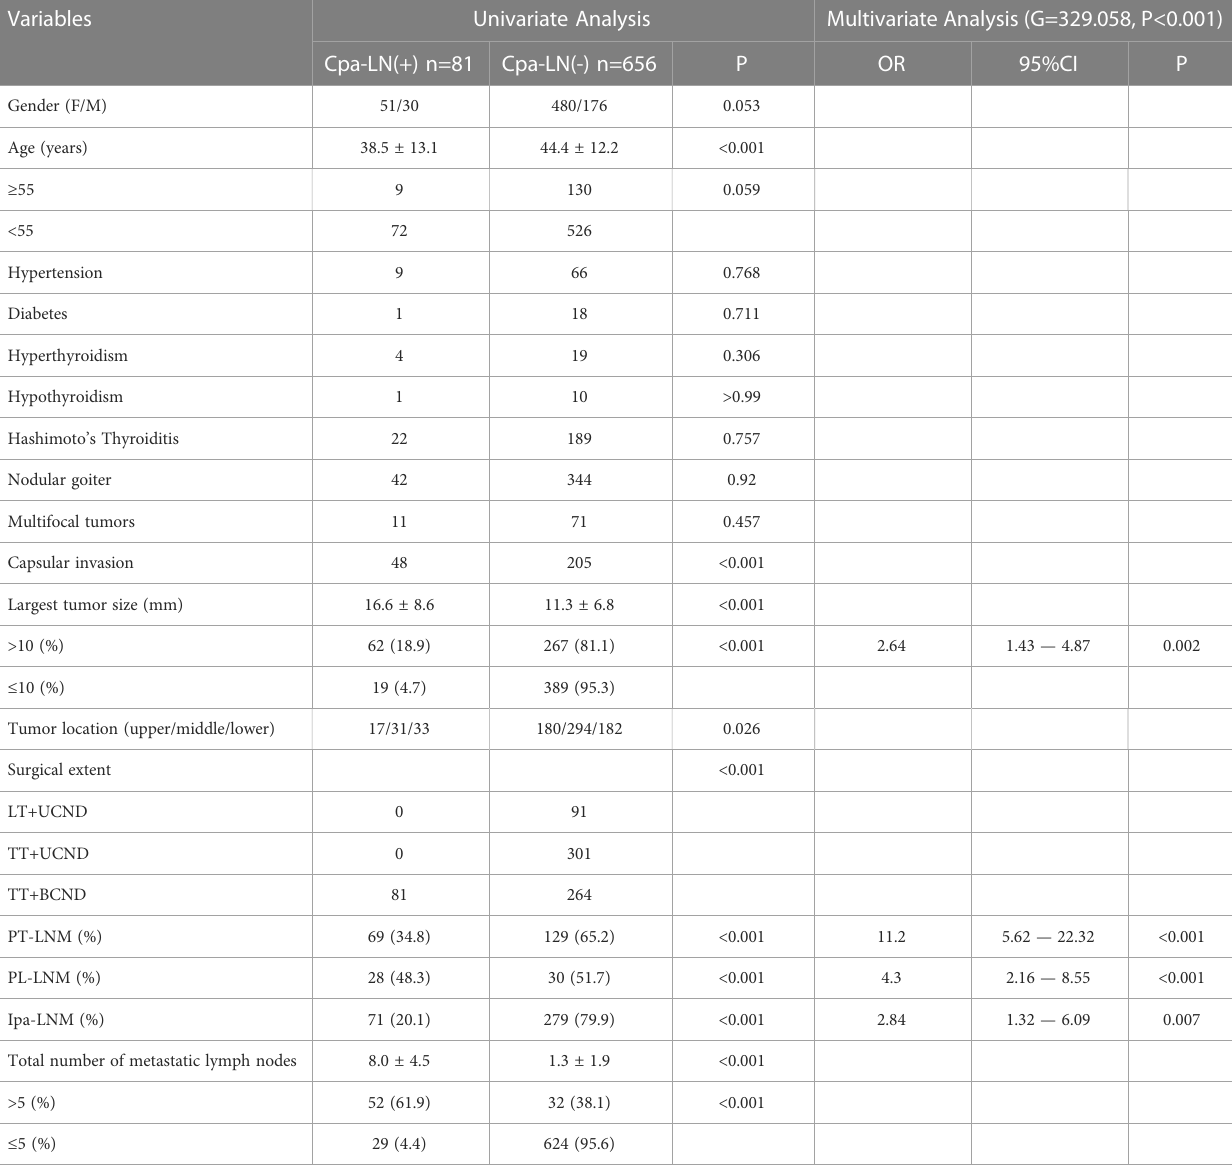
TABLE 4 The risk factors for contralateral paratracheal lymph node metastasis.